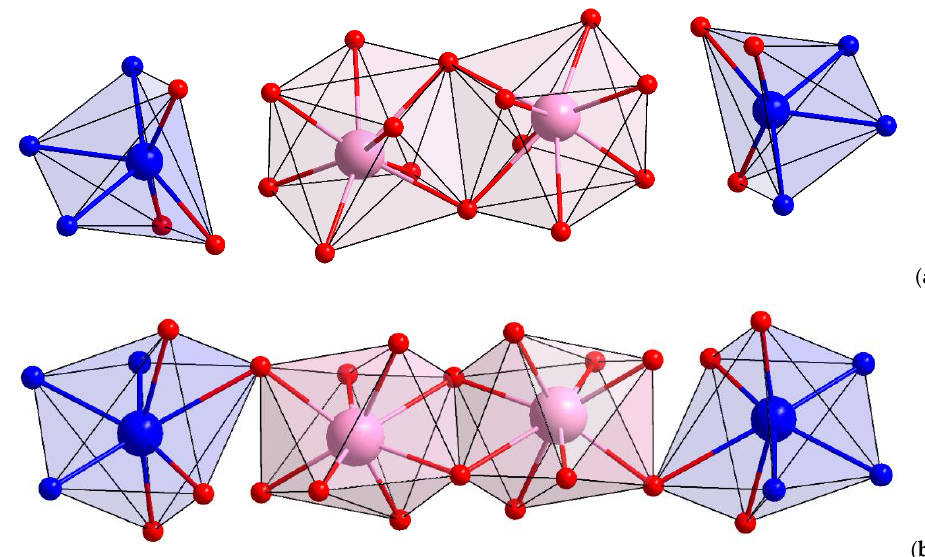
Figure 3. Coordination polyhedra of metal ions in 2 Eu ( a ) and 3 Eu ( b